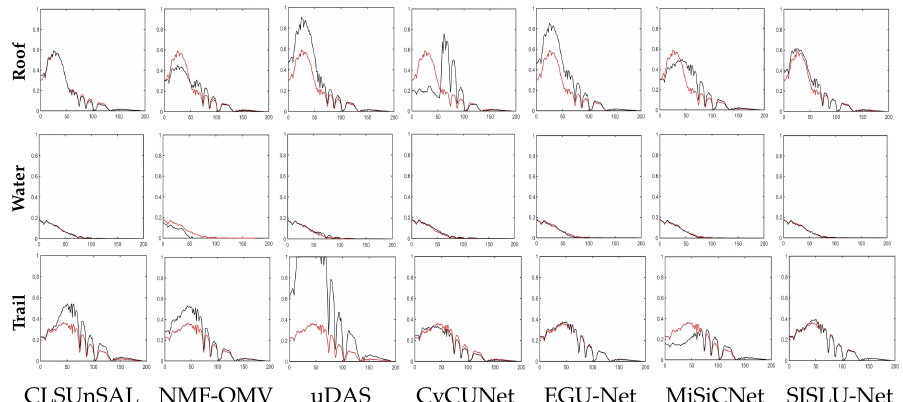
Figure 14. Estimated endmembers by all competing methods on the Washington DC Mall Dataset. Red: the ground truth endmembers; Black: the estimated